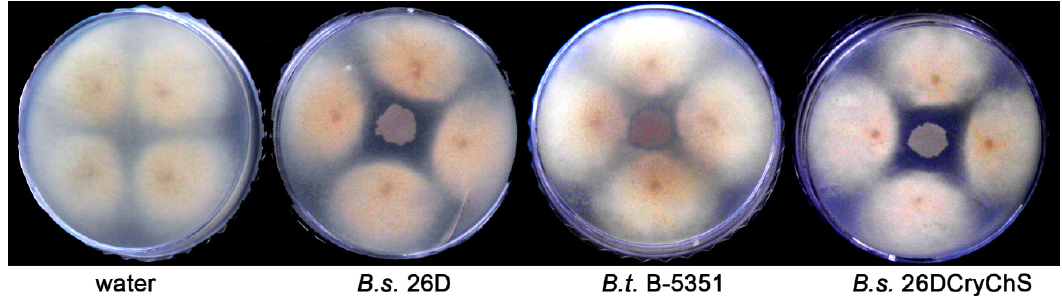
Figure 2. Antagonistic effect of Bacillus sp. on pathogenic oomycete P. infestans growth in vitro .